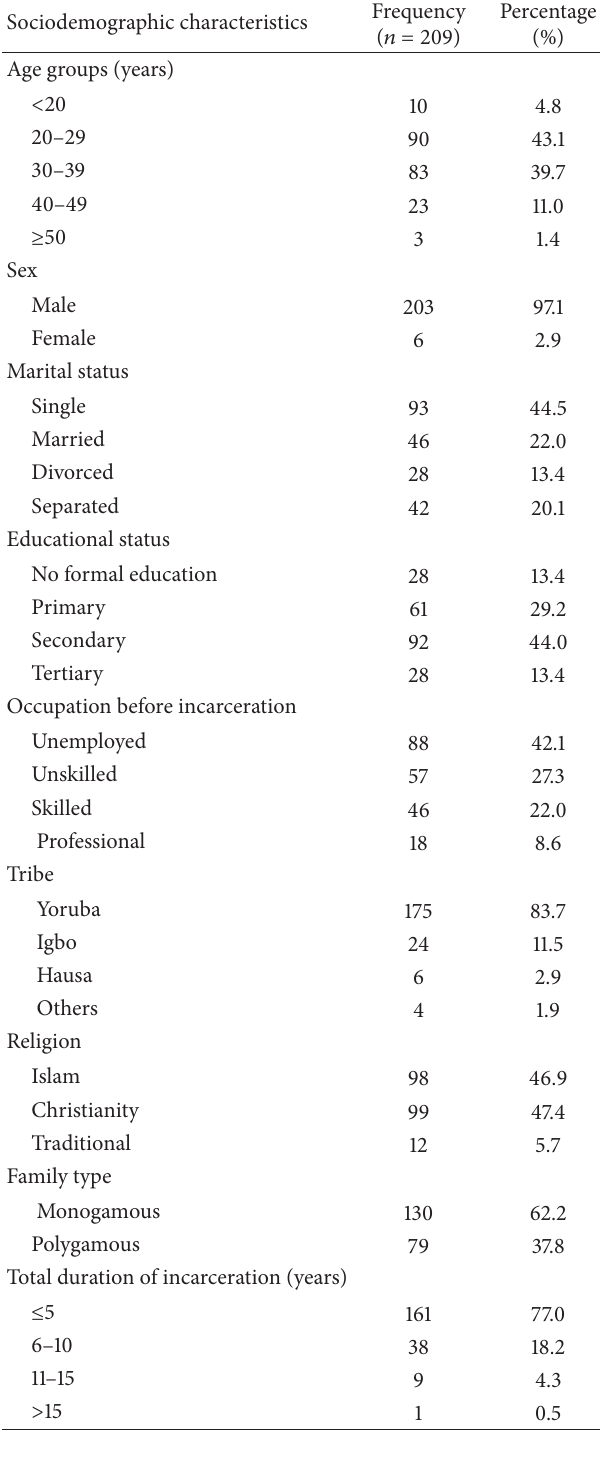
Table 1: Sociodemographic characteristics of